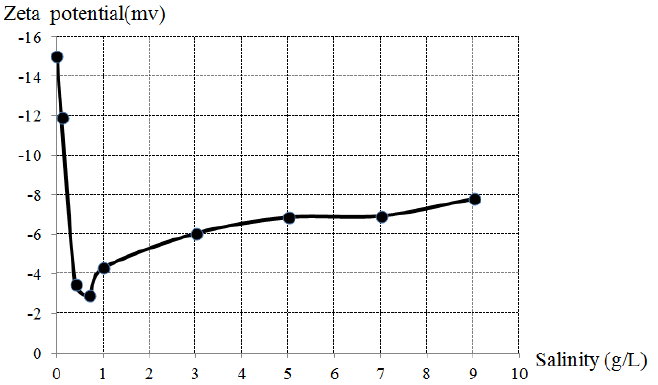
Figure 4. Zeta potentials of MNBs in different